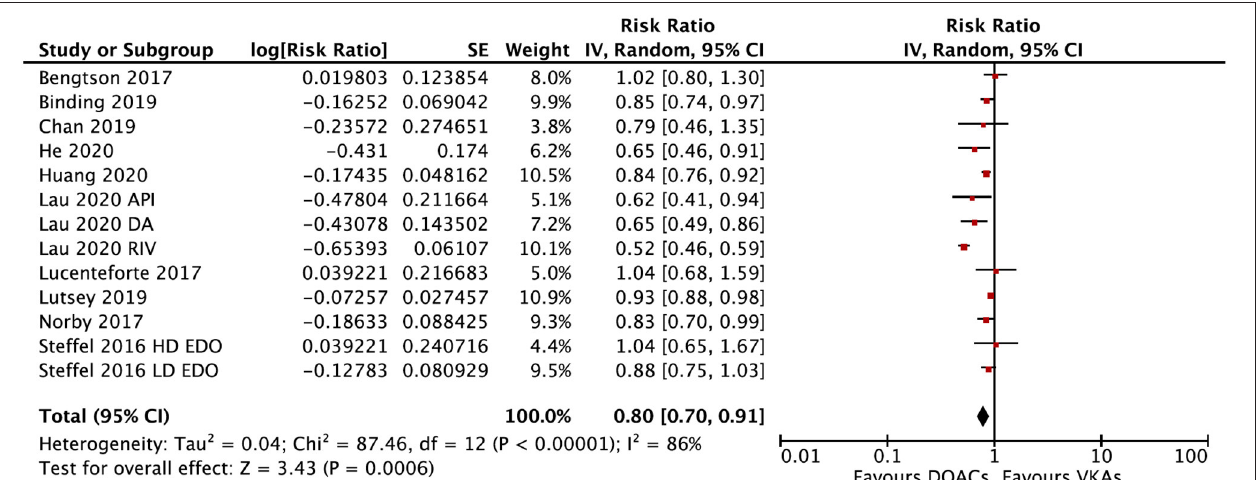
FIGURE 1 | Comparing the risk of any fracture of DOACs vs. VKAs in AF patients. AF, atrial fibrillation; DOACs, direct oral anticoagulants; VKAs, vitamin K antagonists; DA, dabigatran; RIV, rivaroxaban; API, apixaban; EDO, edoxaban; CI, confidence interval; HD, high dose; LD, low dose; SE, standard error; IV, inverse of the